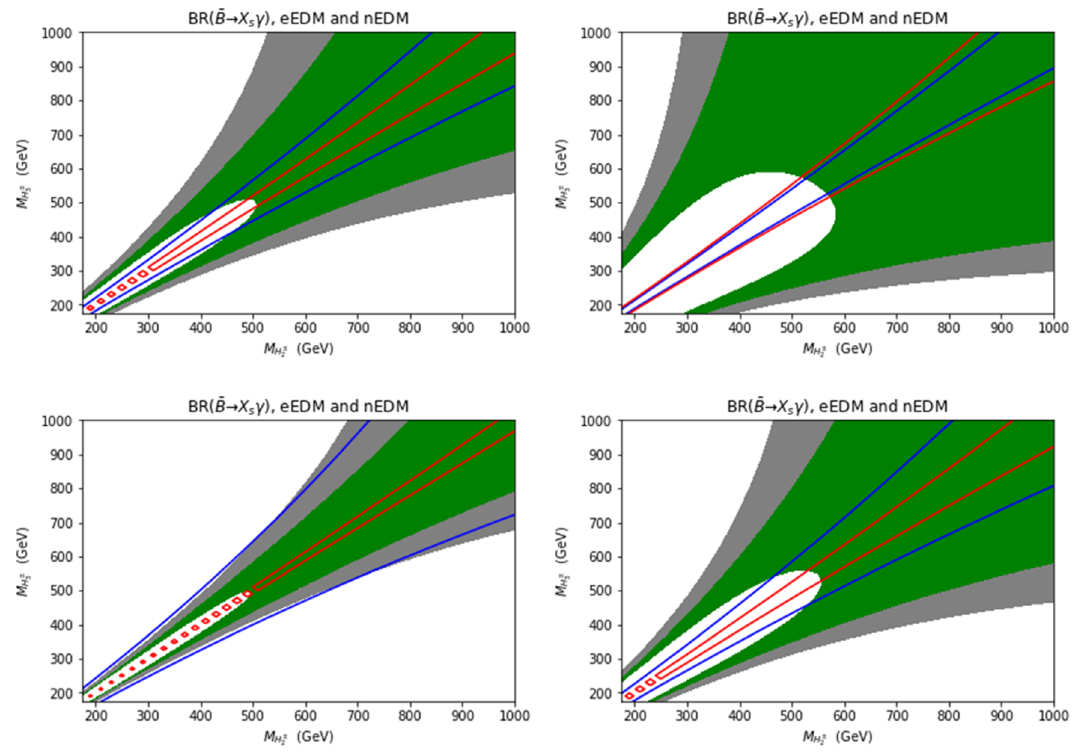
Figure 20 . Same as figure 17 but with θ = − π/ 4